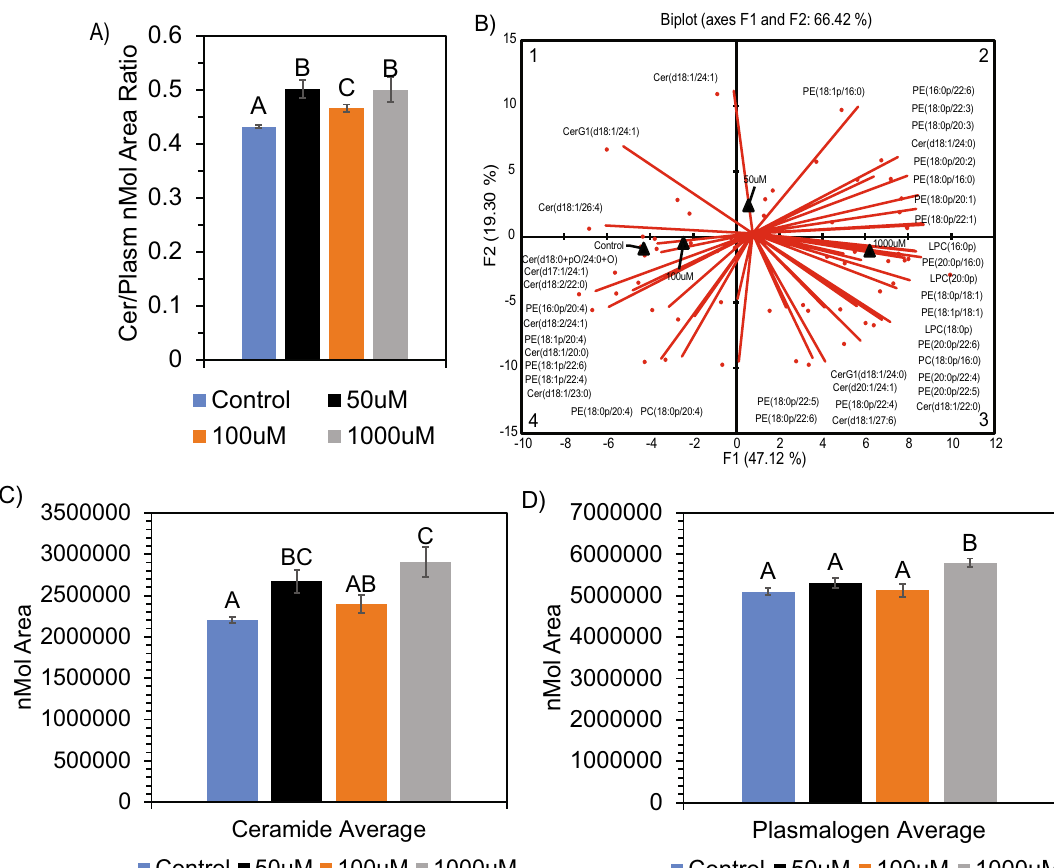
Figure 5. Alteration in ceramide and plasmalogen composition in neuronal cells after SCFA treatment. ( A ) Increased ratio of ceramide: plasmalogens after treatment. ( B ) PCA biplot showing alteration in both ceramide and plasmalogen molecular species between control/100 μM, 50 μM, and 1000 μM SCFA treatment. ANOVA of average nmol area for both ceramide ( C ) and plasmalogen ( D ) showed significant (p < 0.05) difference after SCFA treatment. Ceramides show an average fold-change increase of 1.32 and plasmalogens show an average fold-change increase of 1.14 after 1000 μM treatment. Bar charts representative of means ± standard error. Means represented by different superscripts are significantly different at p <